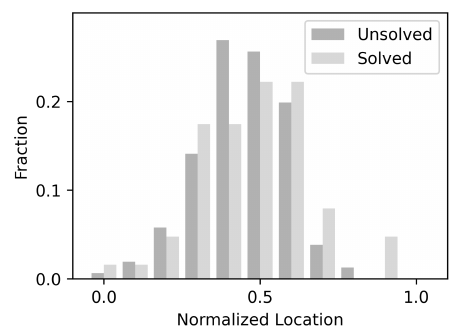
Figure 9. Average normalized locations of the first or the last so- lution bigrams. For the trials when the anagram puzzle was un- solved, the average location was 0.50 with an SEM of 0.011, and for the solved trials, the average location was 0.52 with a standard error of